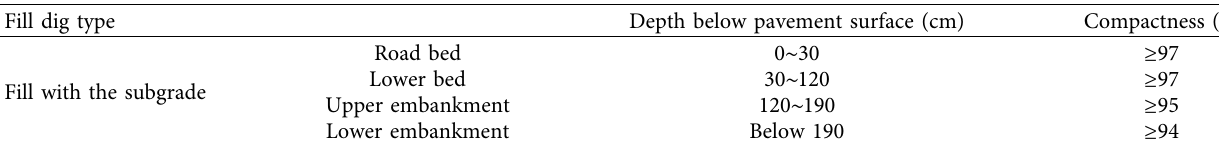
Figure 2: Mesh division model schematic diagram. Table 1: Subgrade compaction degree.